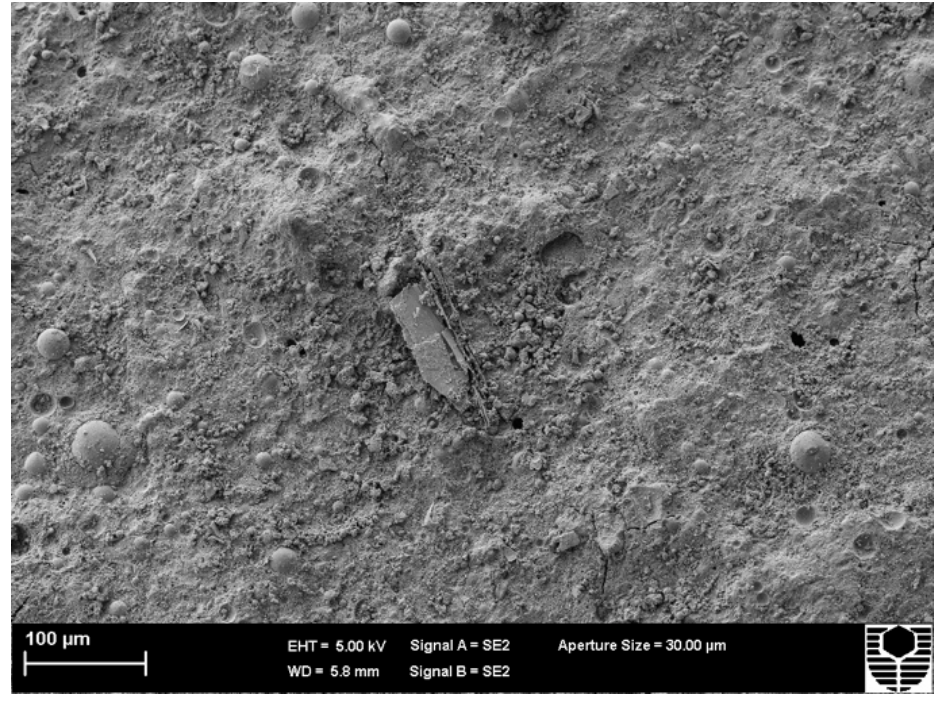
Figure 6. Microstructure of Mix 3 for FA and MK-based geopolymer.